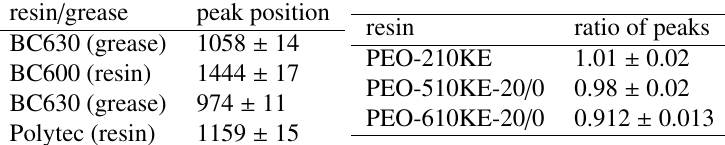
Table 1. Positions of the cosmic peak for the optical grease BC630 and optical resins BC600 and Polytec (left); ratios of the positions of the cosmic peak for PEO-210KE, PEO-510KE-20 / 0, PEO-610KE-20 / 0 optical resins and BC600 (right).